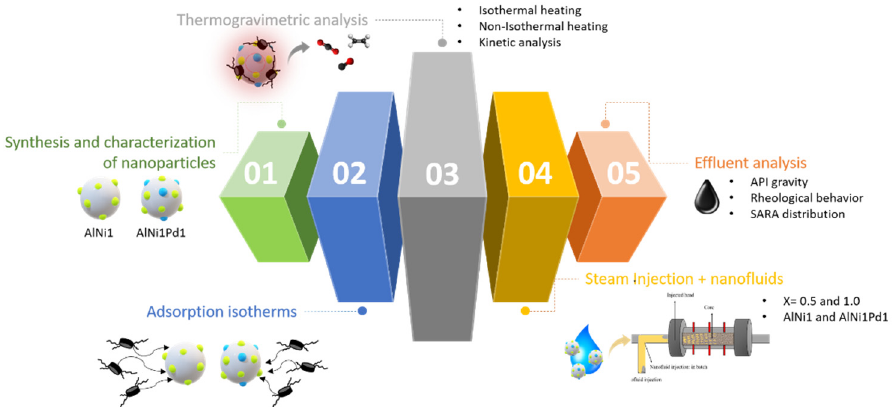
Figure 1. Workflow was conducted in this